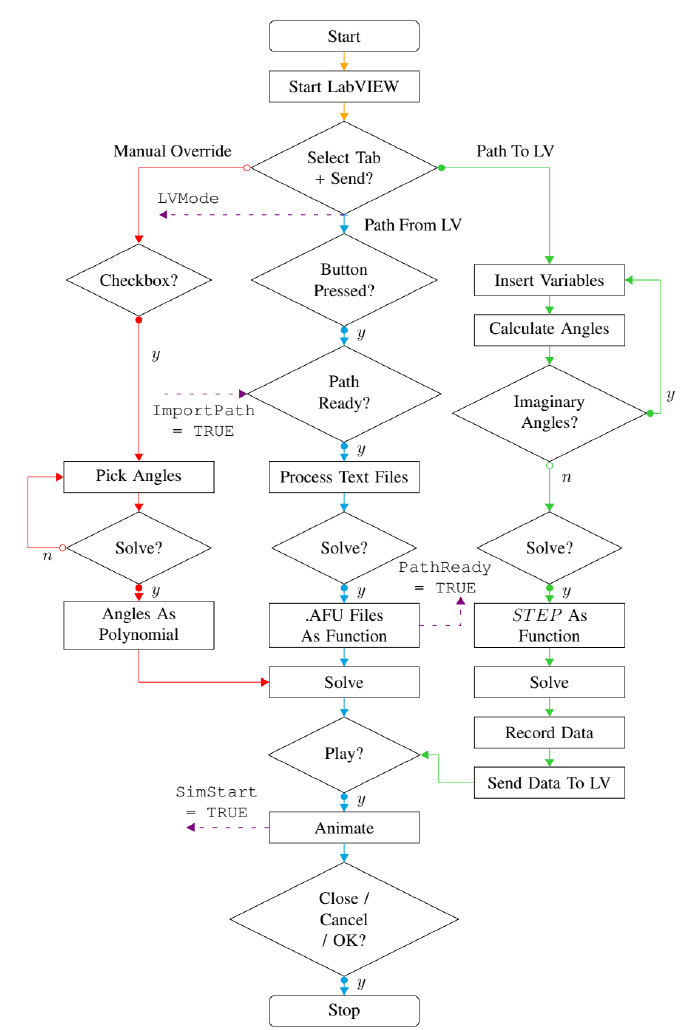
Figure 6. Flowchart of the operational procedures in the VisualBasic application (red path represents the manual override mode, the blue path represents the import motion mode and the green path represents the export motion mode). LV is the abbreviation of